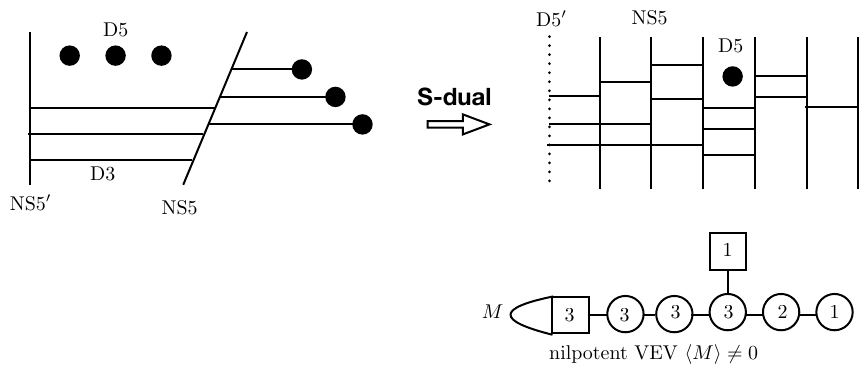
Figure 1 . The brane realisation of mirror pairs (4.4) and (4.11) with N = 3 and k = 3. superpotential (4.12). Observe that the remaining part of the brane con(cid:12)guration is still = 4 supersymmetric. We thus expect the presence of the term f W N =4 N